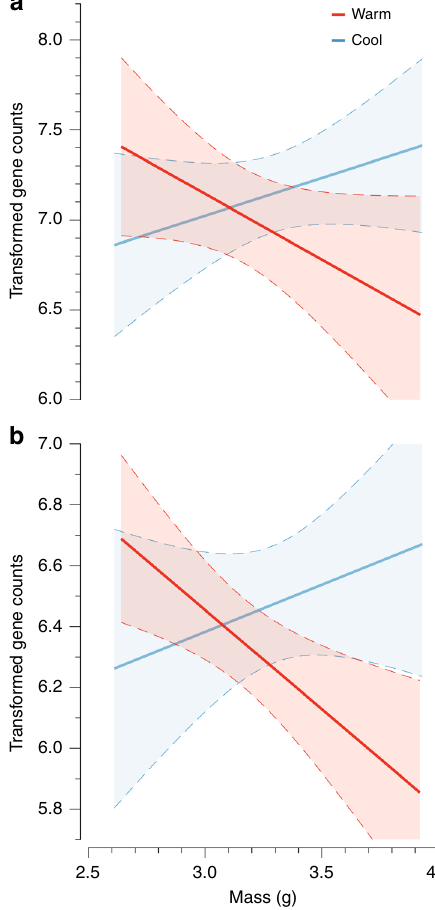
Fig. 5 Blood vessel formation genes within skin resistance modules related to variation in mass and temperature. The fi gure illustrates two genes within the skin resistance modules that exhibit an interaction between mass and temperature. The temperature treatments are also identi fi ed in red (warm) and blue (cool) clearly illustrating an effect of temperature treatment. The fi gure illustrates the interaction for stromal interaction molecule 1 ( STIM1 ) ( a ) and rap guanine nucleotide exchange factor 1 ( RAPGEF1 ) ( b ). These genes provided insight into the mechanisms underlying temperature as a cue for r i as they both have the same role in blood vessel development. Regressions are shown with 95% con fi dence